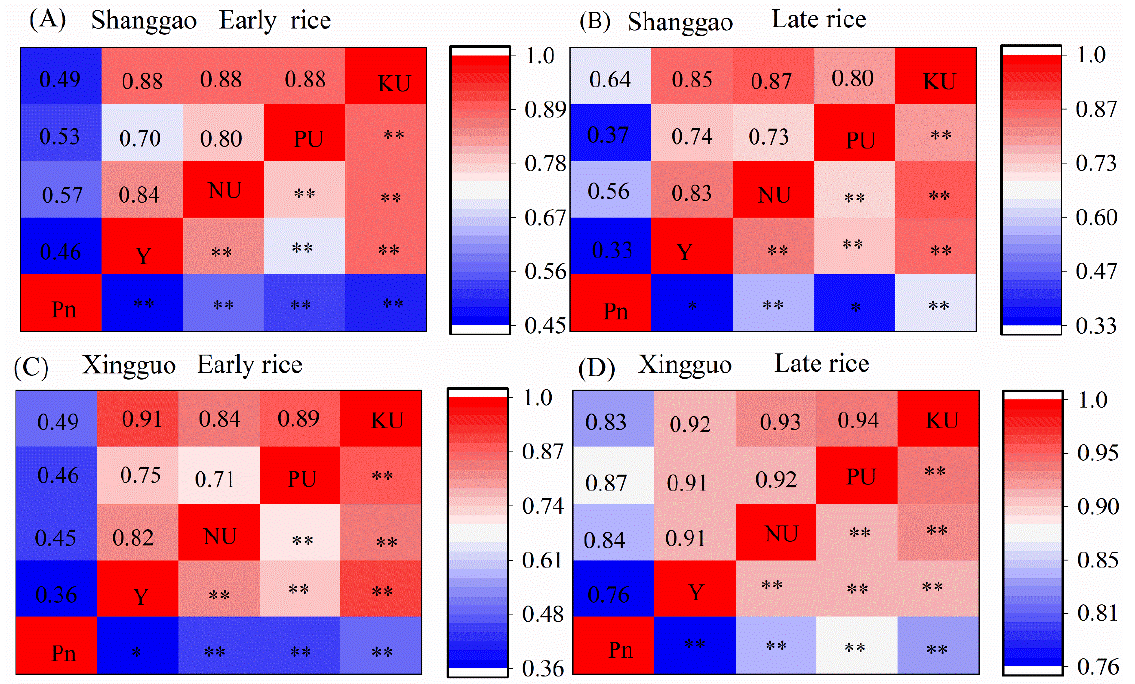
Figure 9. Correlation between the photosynthetic rate at the heading stage and the N, phosphate and potassium uptake at the mature stage of the double cropping rice yield( A – D ). * and ** represent significant difference at the 5% and 1% probability levels. Pn, photosynthetic rate; Y, yield; NU, N uptake; PU, phosphate uptake; KU, potassium